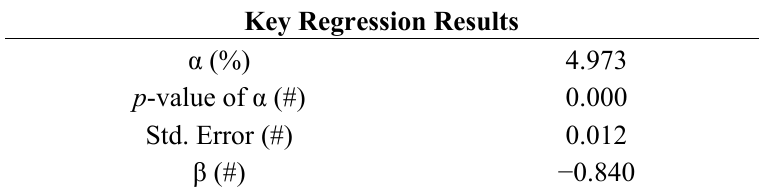
Table 3. Bimonthly Performance of Volatility Beta-Arbitrage—Normal Hedge, Trip